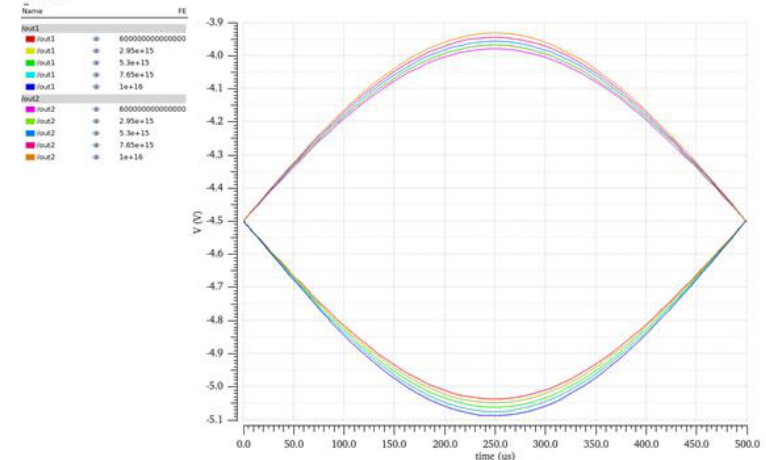
Fig. 4. Circuit diagram of a two-stage differential amplifier.